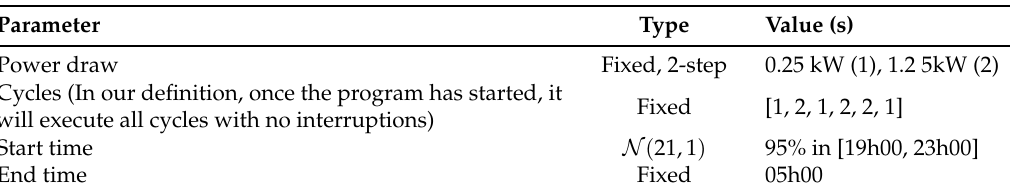
Table 2. Values for the dishwasher population.